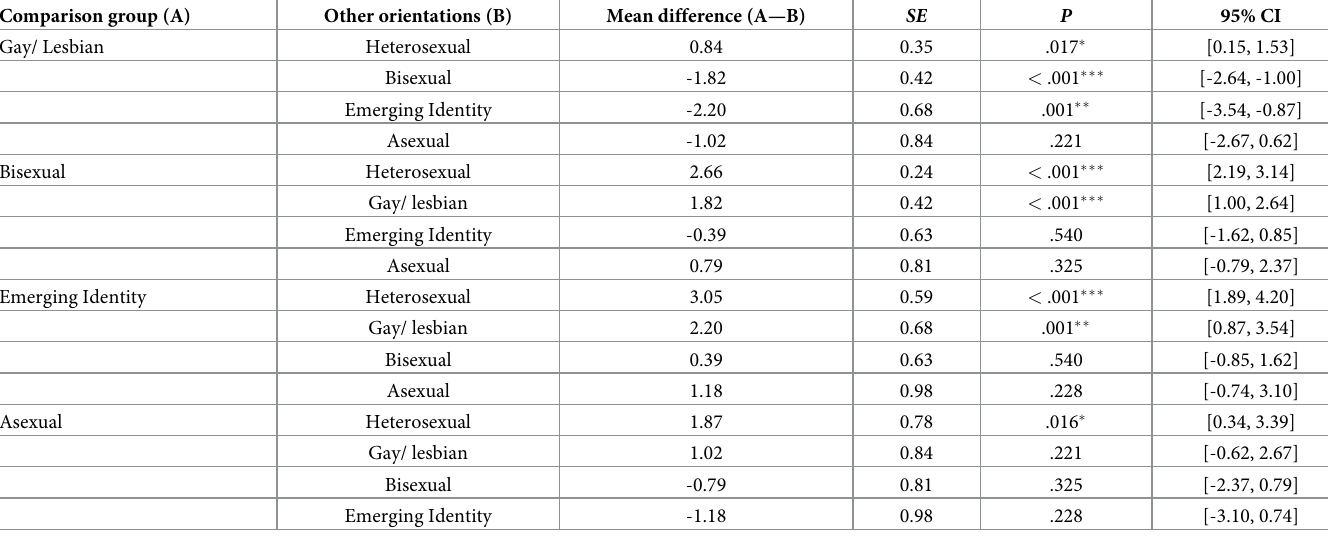
Table 4. Comparisons of depression symptom scores by sexual orientation. Comparison group (A)